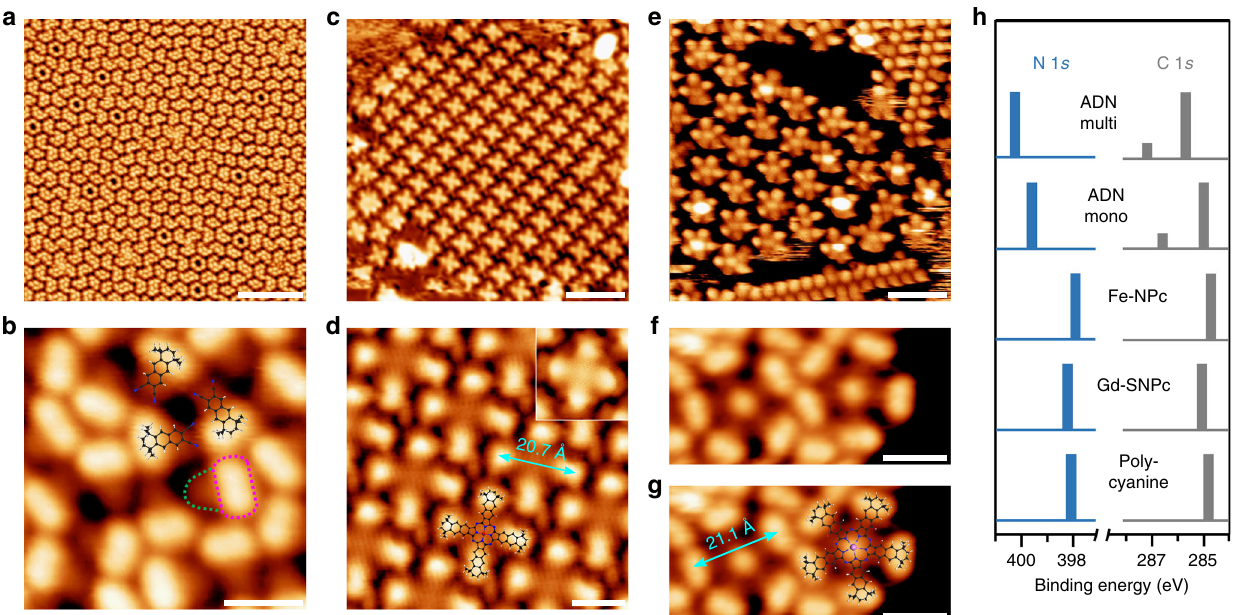
Fig. 2 On-surface synthesis of Fe-NPc and Gd-SNPc. a STM image taken after vapor deposition of a monolayer of the precursor ADN onto Ag(111) at 300 K. c , e STM images taken after subsequent deposition of a low coverage of iron (0.13 ML) and gadolinium (0.06 ML), respectively, on the ADN monolayer followed by annealing to 450 K. b , d , f Magni fi ed views of the samples in a , c , e , respectively. Molecular models of ADN and Fe-NPc are overlaid in b , d . The inset in d shows Fe-NPc imaged with the tunneling parameters U = 1.2 V, I = 0.3 nA. g shows f overlaid with a molecular model of Gd-SNPc. Black spheres represent carbon atoms; blue, nitrogen; white, hydrogen; red, iron; pink, gadolinium. Tunneling parameters: a , b , U = − 3.6 V, I = 0.08 nA; c , U = 1.2 V, I = 0.3 nA; d , U = 1.9 V, I = 0.13 nA; e , U = 0.76 V, I = 0.11 nA; f , g , U = − 3.6 V, I = 0.11 nA. Scale bars, a , 10 nm; b , d , f , g , 1.5 nm; c , 6 nm; e , 4 nm. h Binding energies of C 1 s (gray) and N 1 s (blue) XPS signals for ADN multi- and monolayers, Fe-NPc, Gd-SNPc, and polycyanine chains. The original XP spectra are shown in Supplementary Fig. Fig. 1b: the small (Fe 40 ), large (Gd 41 – 43 ), and the in fi nite (silver surface) templates coordinate different numbers (four, fi ve, and in fi nite) of building blocks that become eventually covalently con- nected. The bene fi ts of the on-surface approach are apparent: the two-dimensional (2D) con fi nement posed by the surface allows only in-plane coordination of ligands with the metal. This results in the formation of the single-decker Gd-SNPc pentamer macrocycle rather than a bis(phthalocyaninato) double-decker complex. The perhaps most surprising advantage of this approach is that it enables the high-yield synthesis of isoindoline polymers, that is, polycyanine chains. The extended [-C = N-] n π -conjugated back- bone of the polycyanine chain reported here makes it an intriguing model for an organic semiconducting polymer with an absorption band in the visible range.